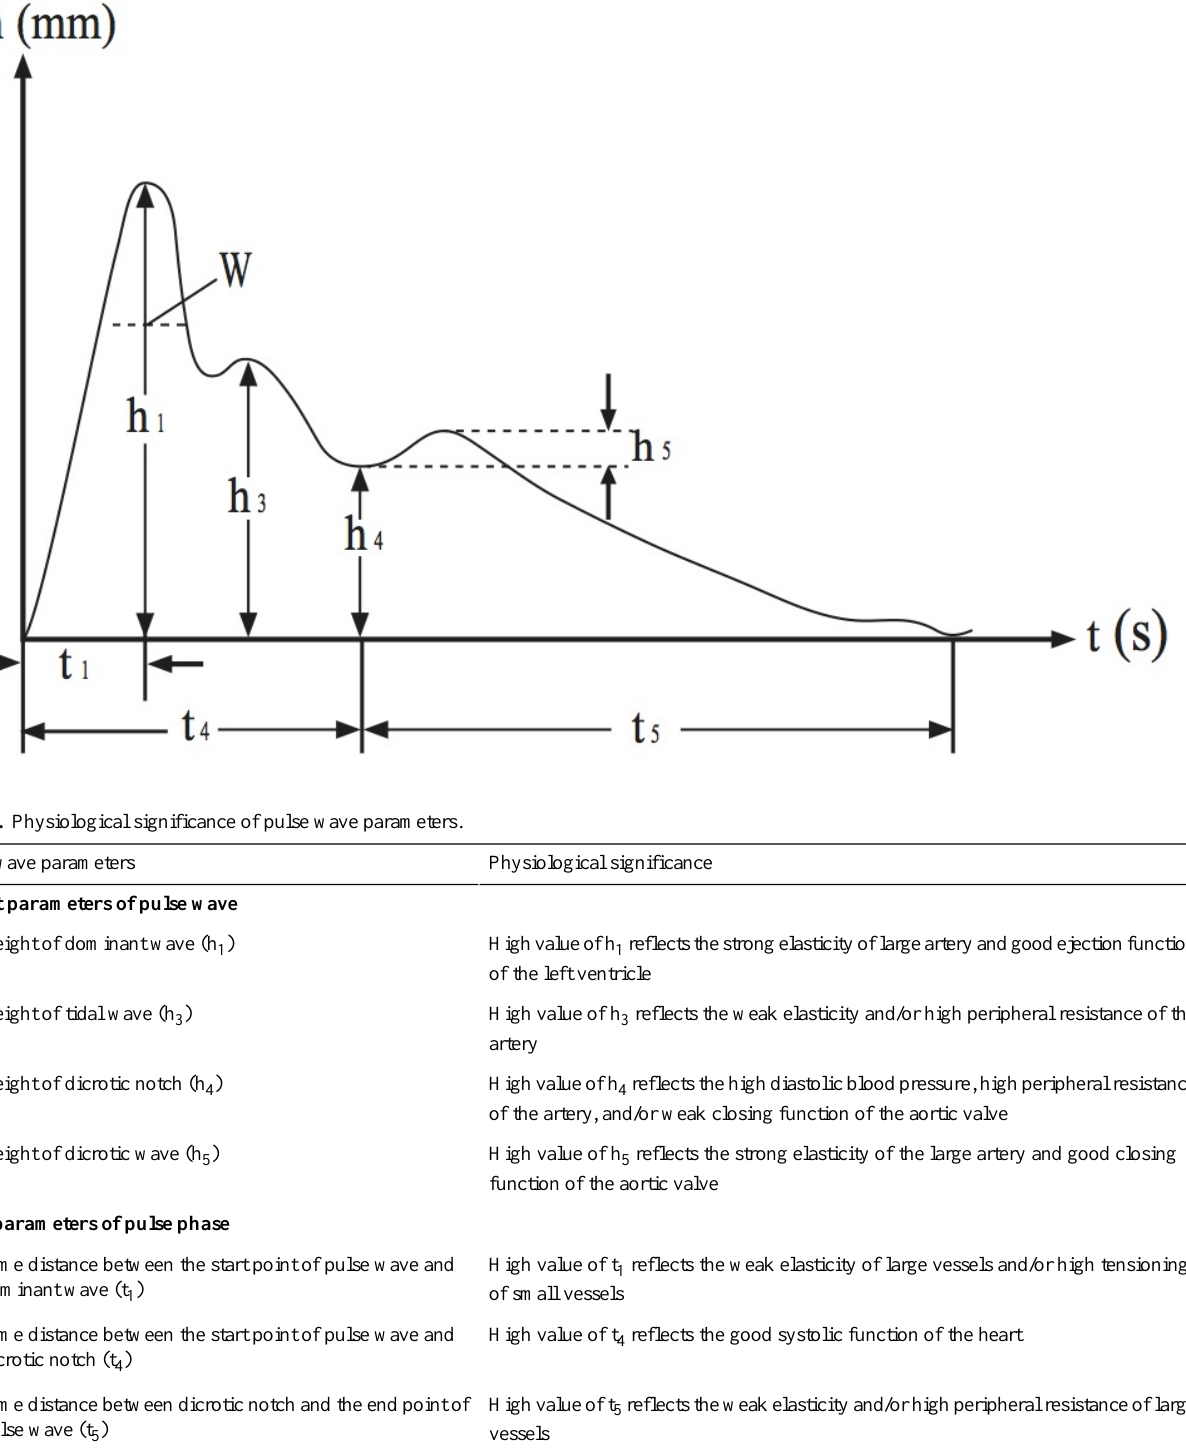
Figure 4. A typical single pulse wave. h: height; h 1 : height of dominant wave; h 3 : height of tidal wave; h 4 : height of dicrotic notch; h 5 : height of dicrotic wave; mm: millimeter; t: time; s: second; t 1 : time distance between the start point of pulse wave and dominant wave; t 4 : time distance between the start point of pulse wave and dicrotic notch; t 5 : time distance between dicrotic notch and the end point of pulse wave; W: width of percussion wave in its one-third height position.